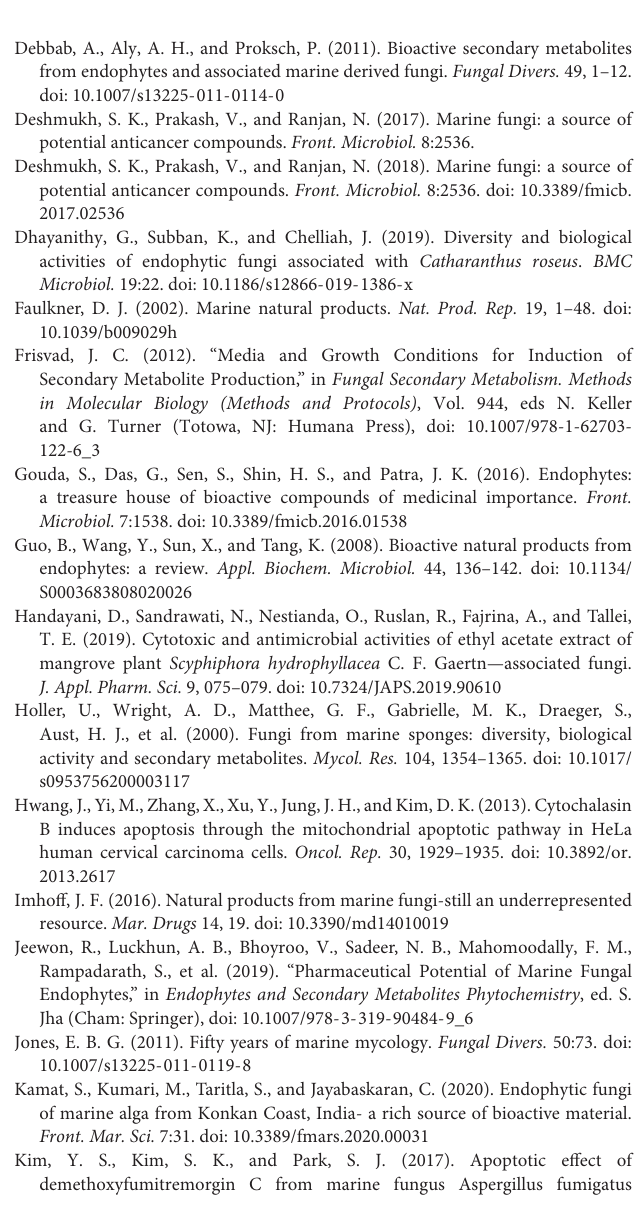
Supplementary Figure 6 | Thin-layer chromatography (TLC) profile of B. petrensis mycelia (1) and culture filtrate (2) extracts. (A) Analytical TLC plate (sample loaded, 100 µ g) and (B) preparative TLC plate (sample loaded, 1.6 mg). Supplementary Figure 7 | (A) Cytotoxic effects of purified metabolites of BpME on different human cancer cell lines. (B) Cytotoxic effects of purified metabolites of BpCFE on different human cancer cell lines. Supplementary Figure 8 | Thin-layer chromatography profile of purified active principles M3, M4 and C2, C5 (sample loaded, 10 µ g) obtained from BpME and BpCFE, respectively. Supplementary Figure 9 | (A) High-performance liquid chromatography (HPLC) profile of M3 and M4 compounds in comparison with mycelial extract. (B) HPLC profile of C2 and C5 compounds in comparison with culture filtrate extract.